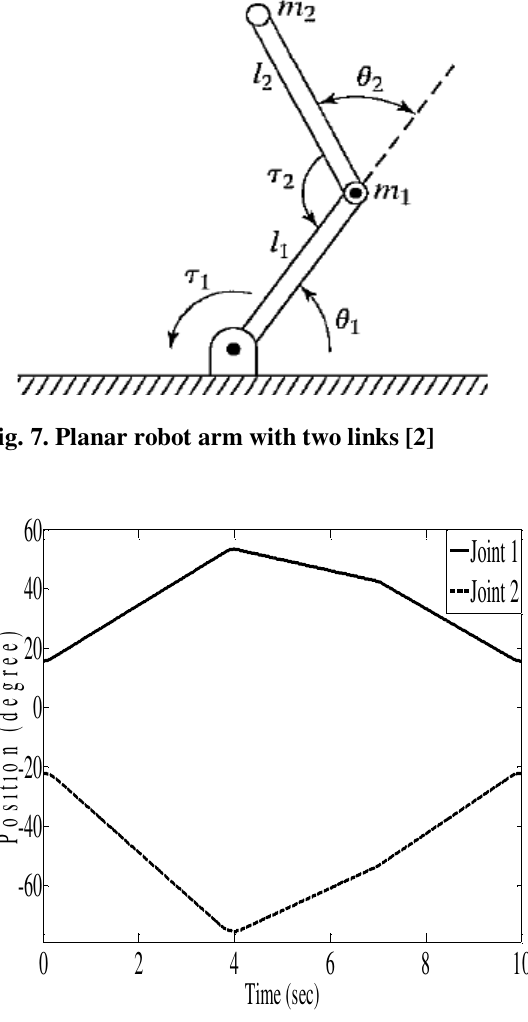
Fig. 8. Two-link joint's desired trajectory obtained by proposed method.